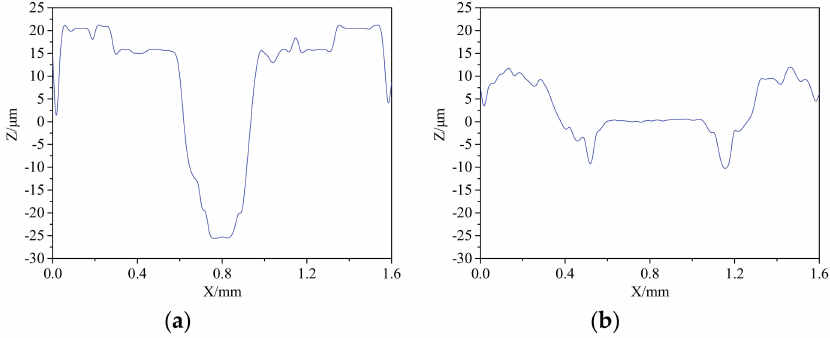
Figure 14. The profile perpendicular to the sliding direction of specimens tested at 50 N / 83.3 mm · s − 1 / 298 K: ( a ) untreated, ( b ) plasma